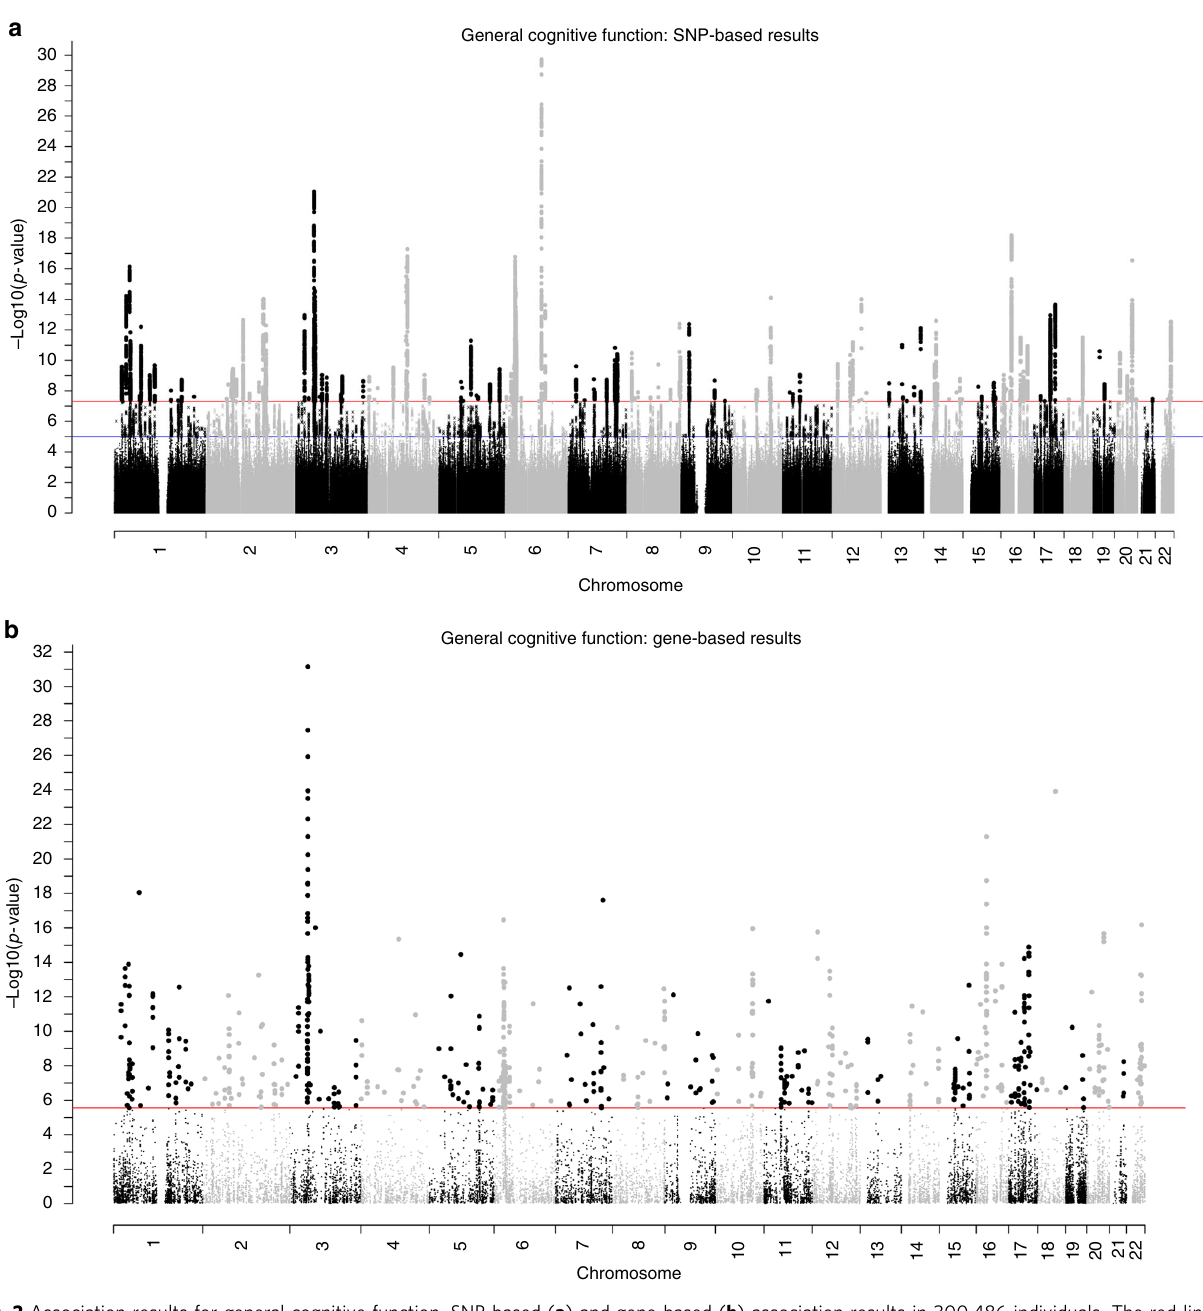
Fig. 2 Association results for general cognitive function. SNP-based ( a ) and gene-based ( b ) association results in 300,486 individuals. The red line indicates the threshold for genome-wide signi fi cance: P < 5 × 10 − 8 for ( a ), P < 2.75× 10 − 6 for ( b ); the blue line in ( a ) indicates the threshold for suggestive signi fi cance: P < 1 × 10 −